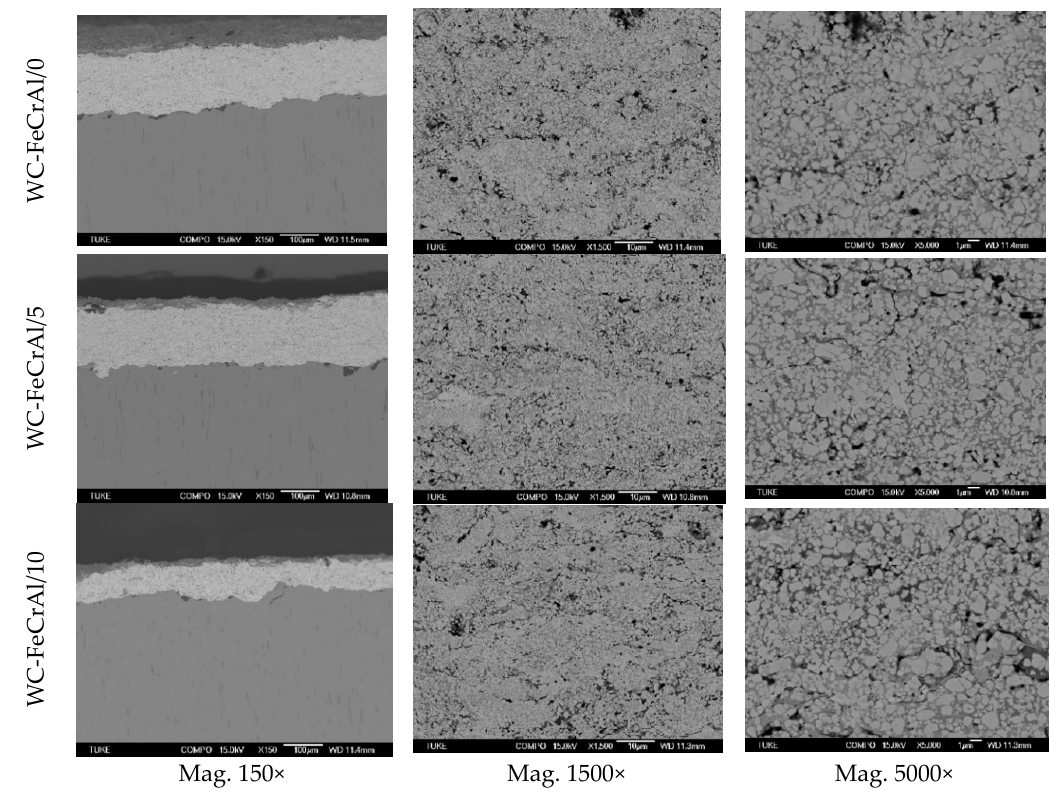
Figure 17. Microstructure of WC ‐ FeCrAl coating.